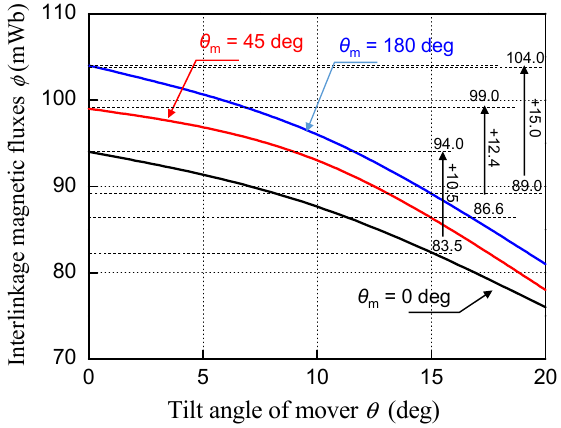
Figure 14. Effect of the number of flux linkage due to the yoke mounting angle.